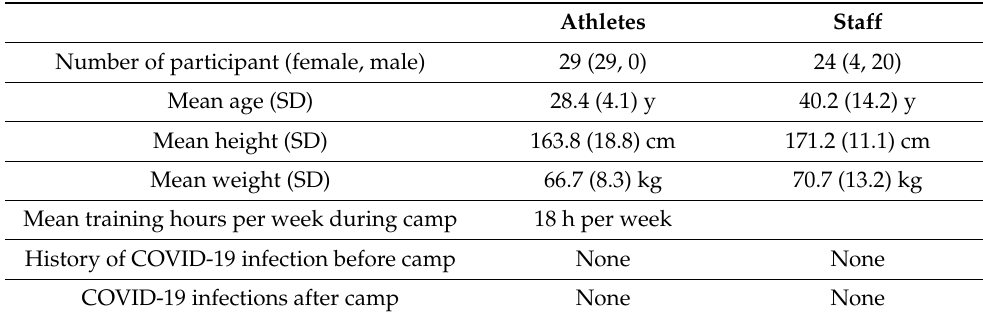
Table 1. Demographic information on the